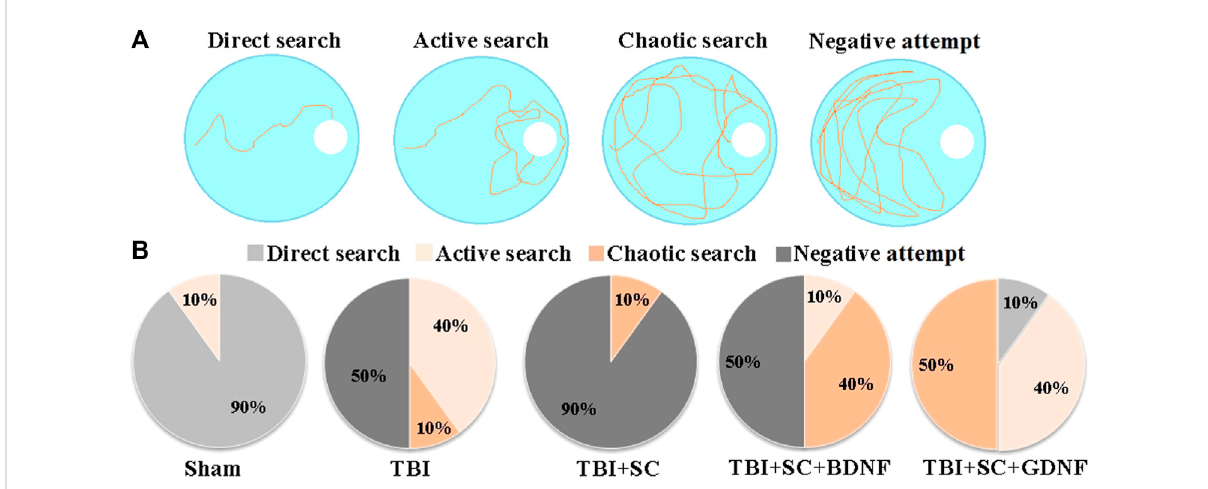
FIGURE 6 Behavioral traits of mice during long-term memory retention test in the Morris water maze. (A) Main target-searching strategies of mice in the Morris water maze; (B) Distribution of target-searching strategies in the experimental groups of mice.